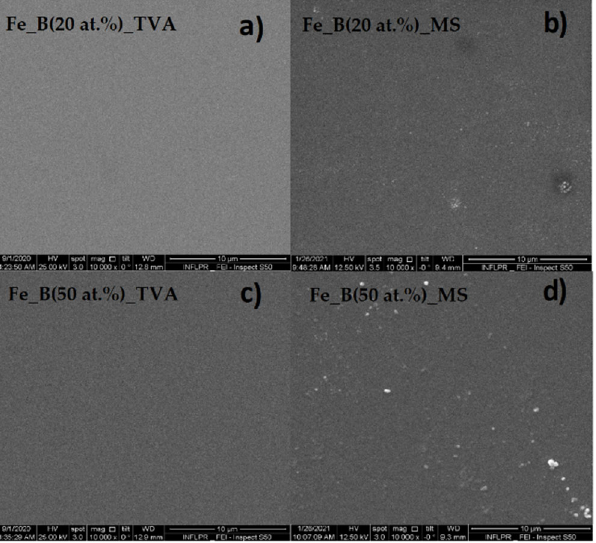
Figure 2. SEM images for samples: ( a ) Fe-B (20 at. % of B) obtained by TVA, ( b ) Fe-B (20 at. % of B) obtained by MS, ( c ) Fe-B (50 at. % of B) obtained by TVA, ( d ) Fe-B (50 at. % of B) obtained by MS.